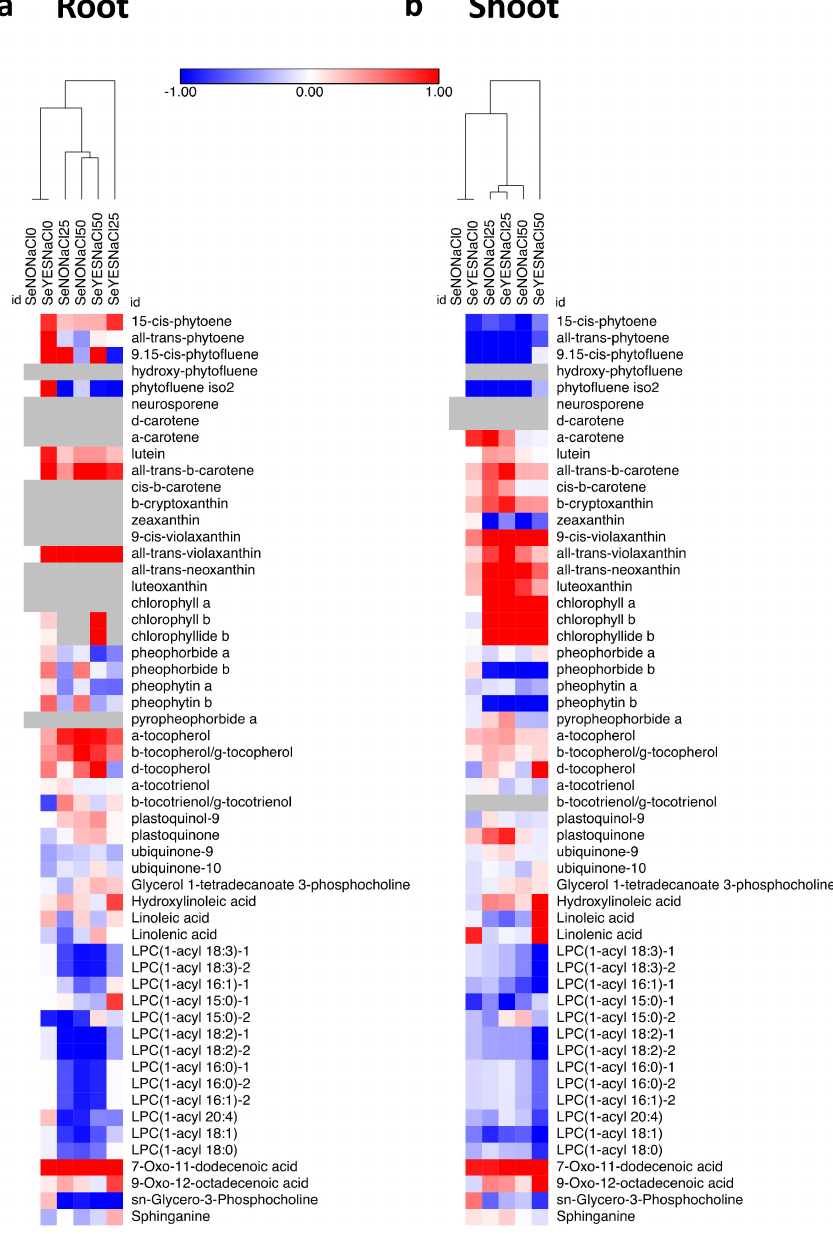
Figure 2. Heatmap visualization coupled with hierarchical clustering (HCL) analysis of non-polar metabolomes in the root ( a ) and shoot ( b ). Data are reported as log2 fold with respect to the Se NO NaCl 0 condition. Only significant metabolites in at least one comparison (treatment vs. Se NO NaCl 0 ), according to a Student t-test (with p -value < 0.05), are reported. Red and shades of red color indicate over-represented metabolites, whilst blue and shades of blue color indicate down-represented metabolites. Data characterized by no alteration in metabolite accumulation are shown in white. Grey boxes indicate metabolites that were not